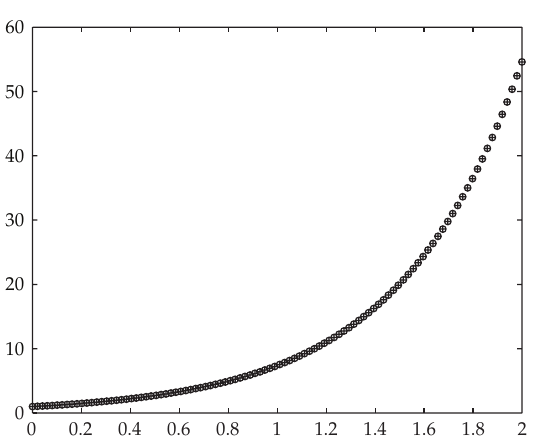
Figure 5: Index 2, T (cid:8) 2, the z -coordinate, “o”-original, “ (cid:9) ”-approximation.